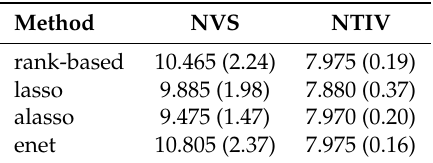
Table 5. Estimated mean and standard deviation of number of variables (NVS) selected and the number of true important variables (NTIV) among NVS with four different models under simulated scenario 1 with 200 replications. The values in parentheseses are standard deviations.